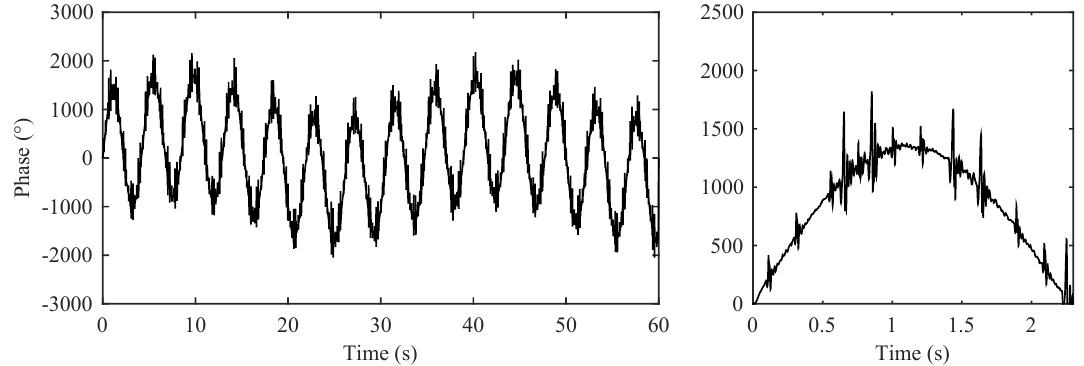
Figure 8. Modelled raw signal represented by IS A in the abdominal region (mRR ∈ <12–16> rpm; mHR ∈ <65–85> bpm, fHR ∈ <80–155> bpm, GA = 35 weeks, orientation of fetus: Right Occiput Posterior (ROP)). ( Left ) 60 s; ( Right ) detail in the form of 2.3 ss.